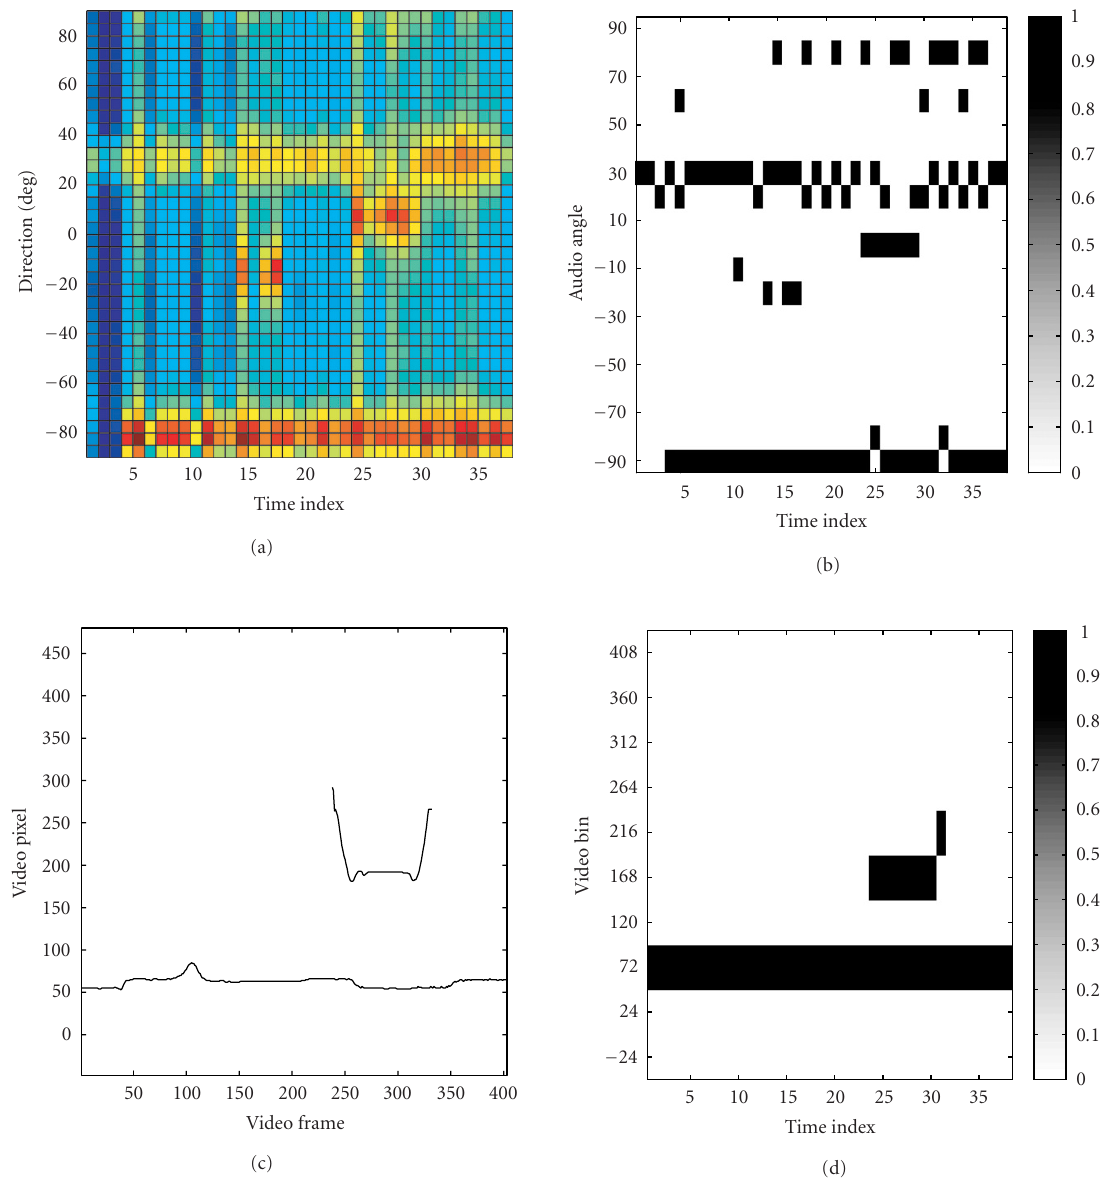
Figure 5: Audio and video information and the corresponding feature vectors. (a) Running spatial spectrum (audio information); (b) audio feature vector corresponding to (a); (c) human tracking; (d) video feature vector corresponding to (c). A vertical slice of (a) and of (c) corresponding to Figures 1a and 1b,